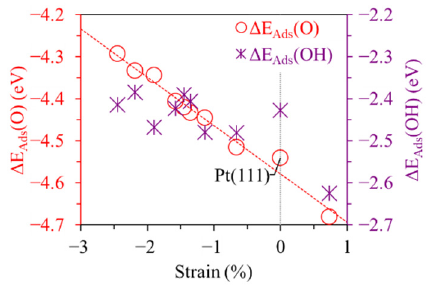
Figure 4. Changes in adsorption energy of OER/ORR intermediates due to the strain effect.